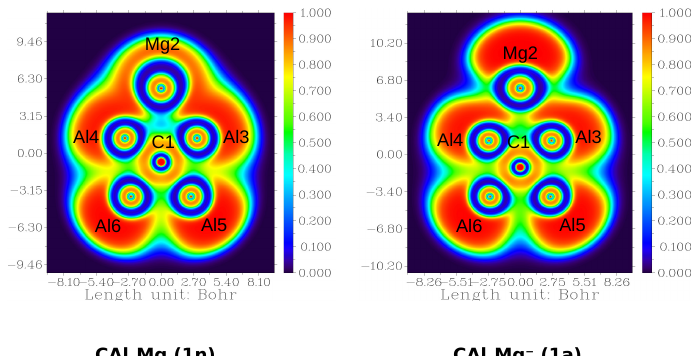
Figure 6. Nucleus independent chemical shifts (NICSs; in ppm) for CAl ( 1a ) calculated at the (U) ω B97XD/6-311++G(2d,2p) level. NICS (1) (green color) is calculated at 1 Å above the ring, whereas NICS(0) (blue color) refers to on the plane values.